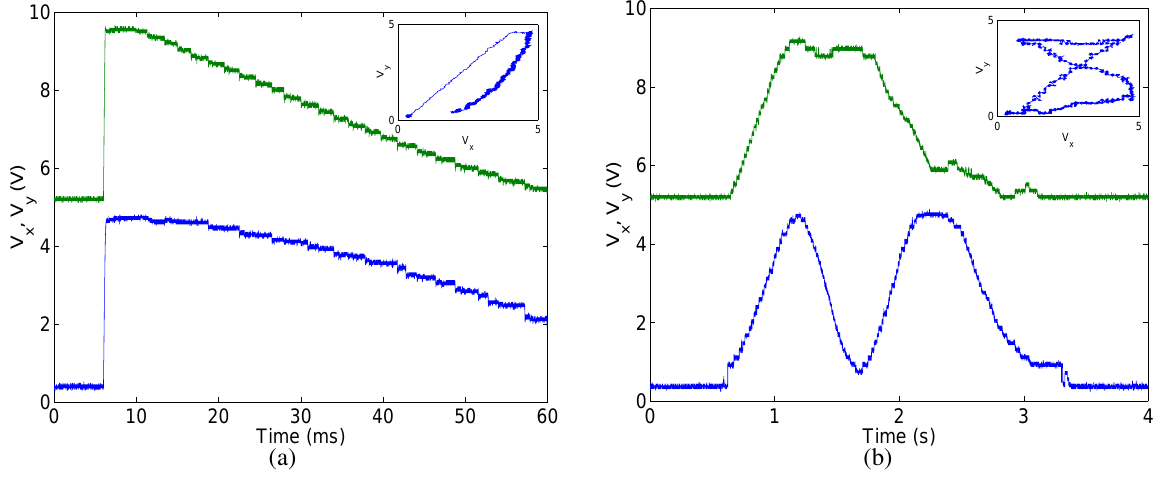
Figure 8 . (a) Output of the analog P2V circuits in response to a target moving from the right top corner to the bottom central part of the sensor’s field of view. The bottom trace ( V x ) reports the x position of the target. The top trace ( V y ), offset in the plot by 5V for sake of clarity, reports the y position of the target. The inset shows V y versus V x . (b) Output of the analog P2V circuits in response to a target moving from the bottom left corner to the top right one, on to the top left, to the bottom right, and back to the bottom left corner. (b) Circuit diagram of a two-dimensional hysteretic WTA